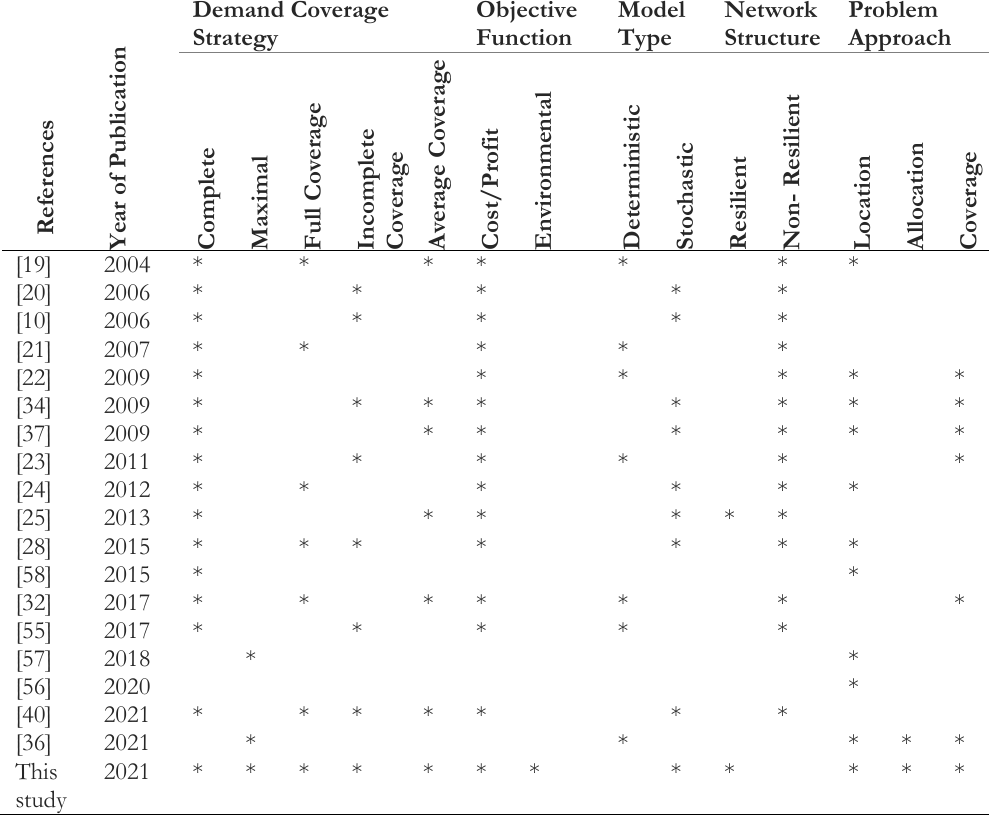
Table 1. Review of the literature on coverage problems, comparison of models, and the research